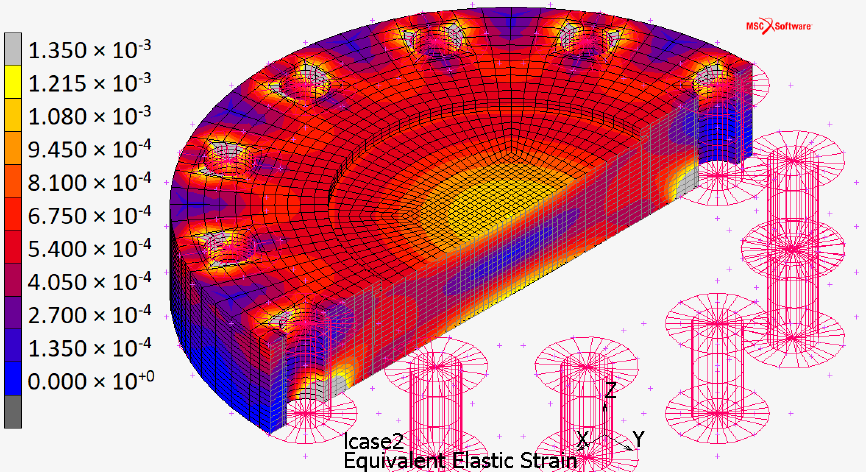
Figure 11. Equivalent strain distribution for the plate when constrained by touching contact with infinitely rigid